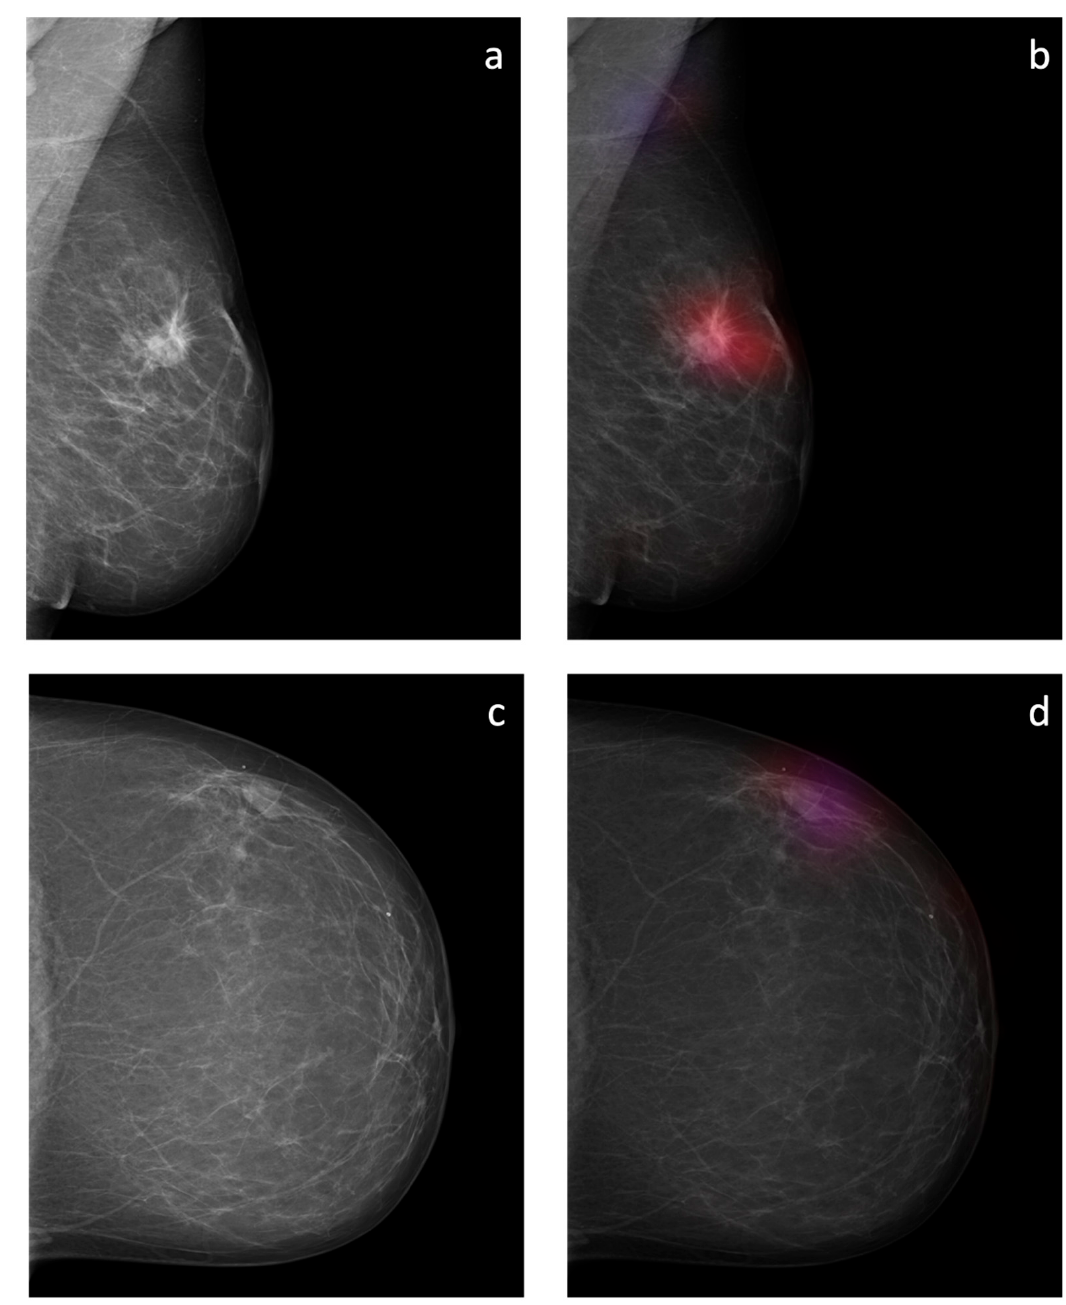
Figure 8. Overlay images of the calculated probability maps ( b , d ) created by the sliding window approach and the corresponding mammographic images ( a , c ) of two patients from the test dataset. In ( a , b ), a suspicious soft tissue opacity is highlighted in red. An area of denser tissue in the left axilla is correctly highlighted as a healthy tissue in blue. In ( c , d ), a probably benign soft tissue opacity is highlighted in purple.